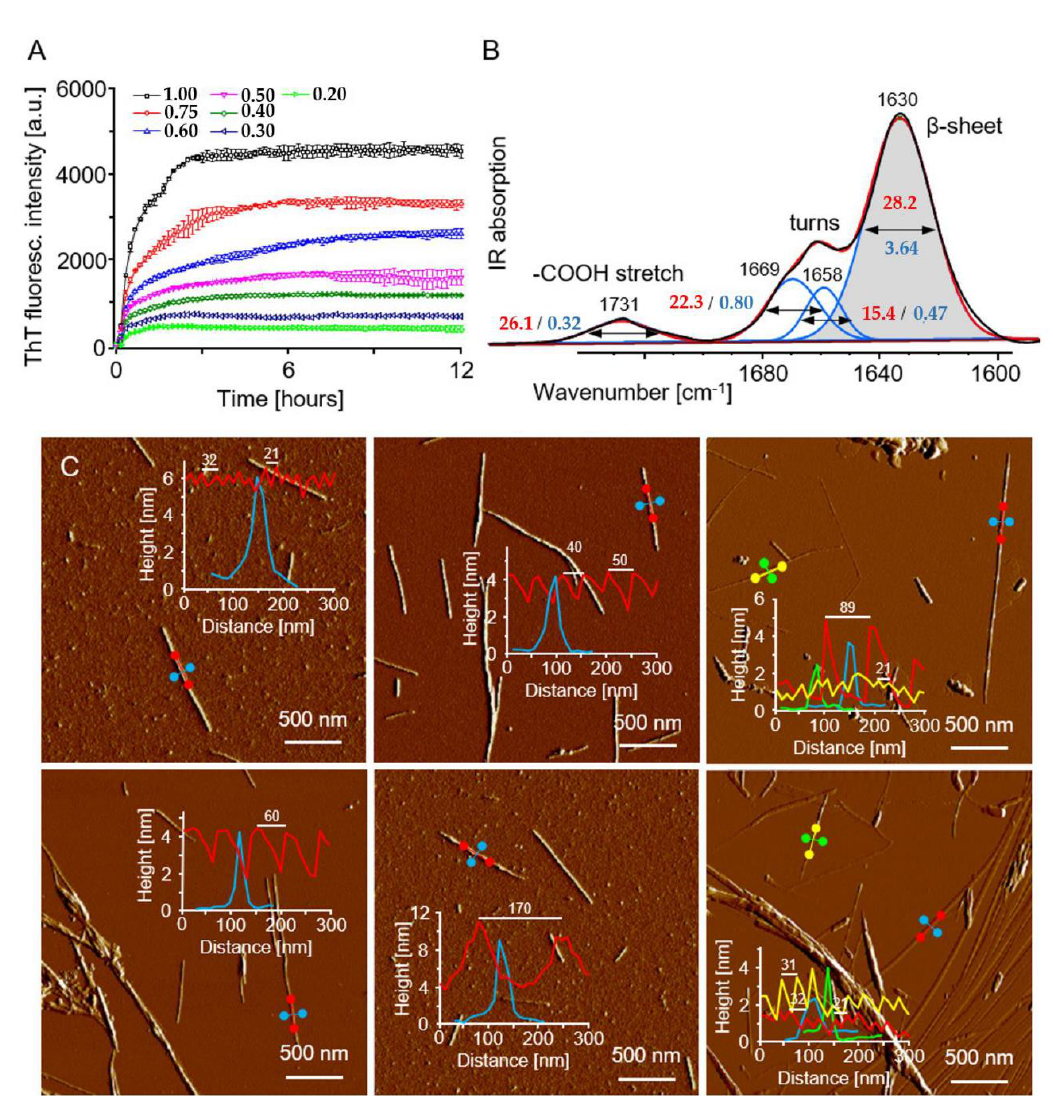
Figure 6. Experimental characteristics of the amyloidogenic ACC 1-13 peptide. ( A ) Kinetics of de novo fibrillization of ACC 1-13 at various concentrations ([mg/mL]) probed with a ThT fluorescence assay at pH 1.9 and 37 °C. ( B ) Infrared absorption of ACC 1-13 fibrils in the amide I band region: the original spectrum (black contour) and peak-fitting with Gaussian components (individual in blue, summation in red), values of FWHM and the integral intensity of component bands are indicated in blue and red, respectively. ( C ) AFM amplitude images of various amyloid specimens of ACC 1-13 . Superimposed cross-sections reveal the height (diameter) and periodicity of fibrils. In each AFM image, the same colors were used to indicate analyzed fibrillar specimen and the obtained cross-section curve